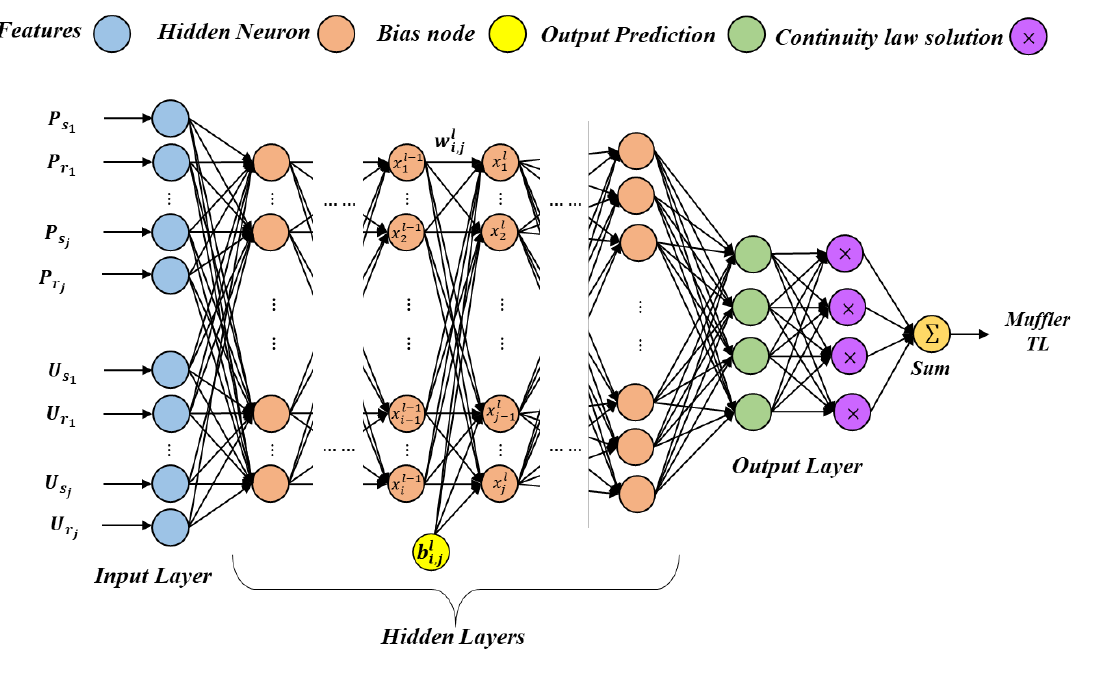
Figure 6. An architecture of proposed CNN with a fully connected network.